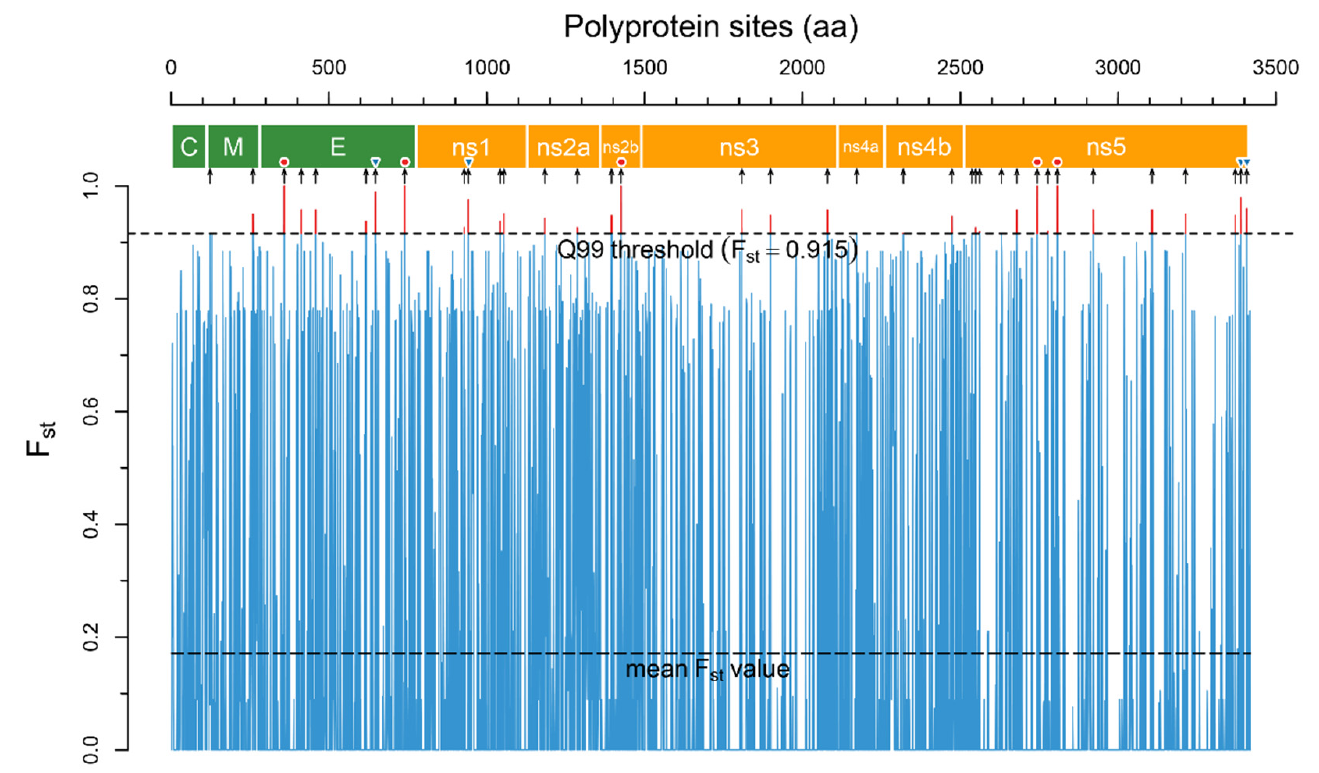
Figure 2. The F st plot across polyprotein sites reconstructed by the R script. F st values were calculated for two groups of aa sequences–encephalitic viruses (TBEV, LIV, POWV) and hemorrhagic viruses (OHFV, KFDV). The narrow blue trace is mean F st values for each polyprotein site, the upper dashed line is the Q99 threshold. The sites of the polyprotein with F st above the Q99 threshold (highlighted by a red color) are potential disease form determinants. The polyprotein scheme was reconstructed based on the annotation of the TBEV strain SofjinKSY (AEP25267.2): the polygons colored in green are structural proteins, those coloured orange are non-structural proteins. The black arrows under the scheme indicate 36 determinant positions in the polyprotein. Red circles above the arrows show absolutely specific positions ( F st = 1.0) and blue inverted triangles show highly specific positions ( F st > 0.96). Table 1. The molecular determinants of clinical manifestation.